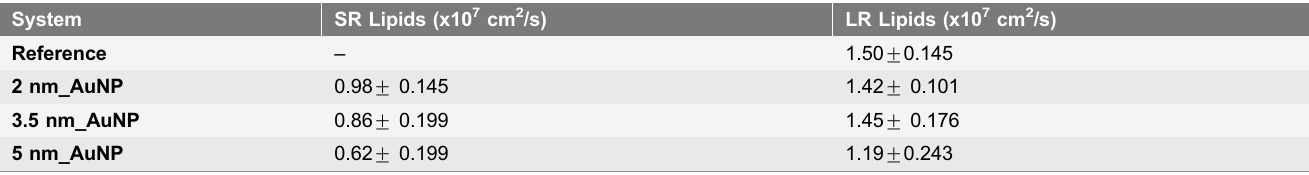
Table 2. Diffusion coefficient for SR and LR